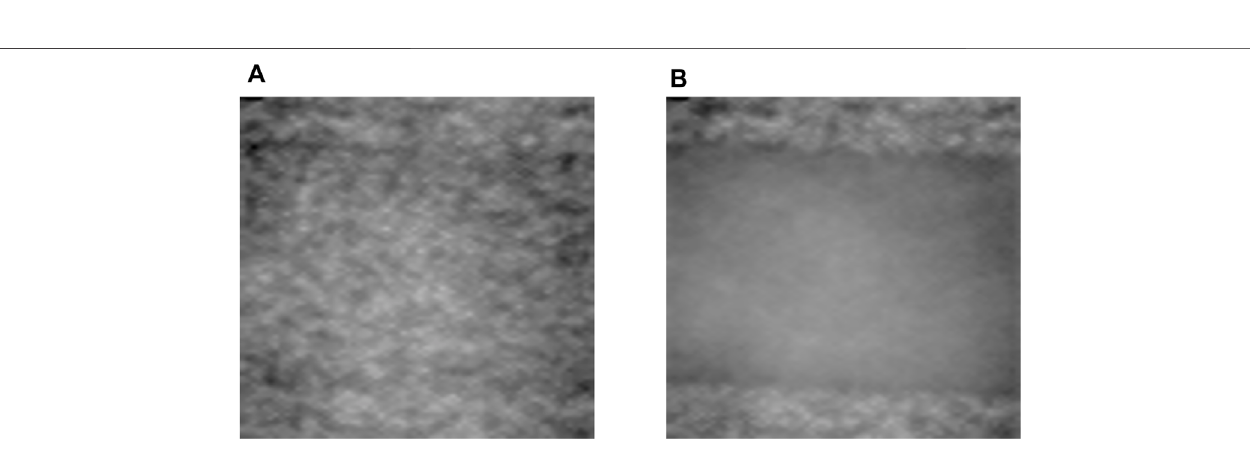
Frontiers in Physics |